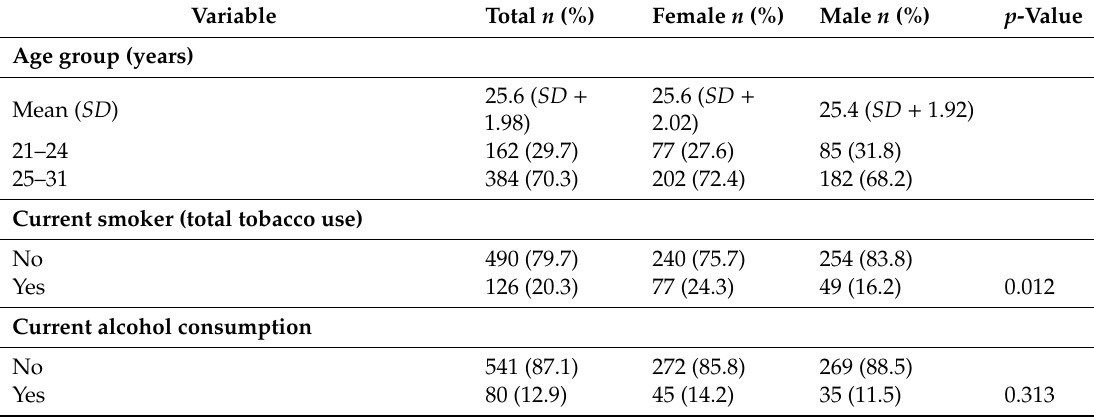
Table 2. Association between variables of binge drinking and variables of metabolic syndrome in Ellisras young adults aged 21 to 31